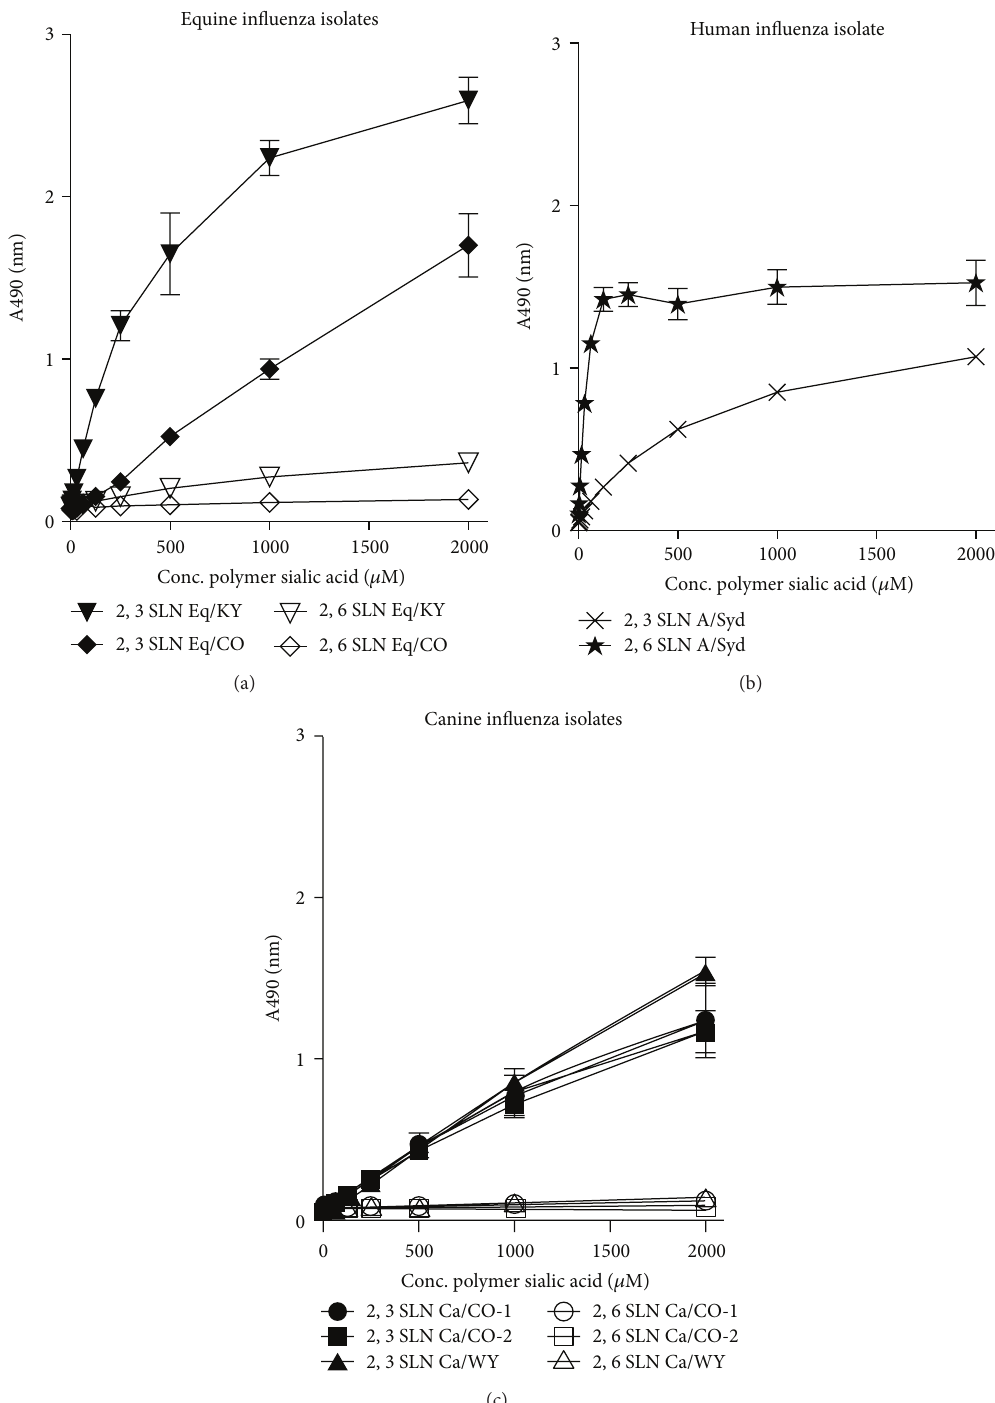
Figure 3: 𝛼 2,3SLN and 𝛼 2,6SLN polymers binding to equine influenza (a), human influenza (b), and canine influenza (c) isolates were determined using a solid-phase binding assay and linear regression